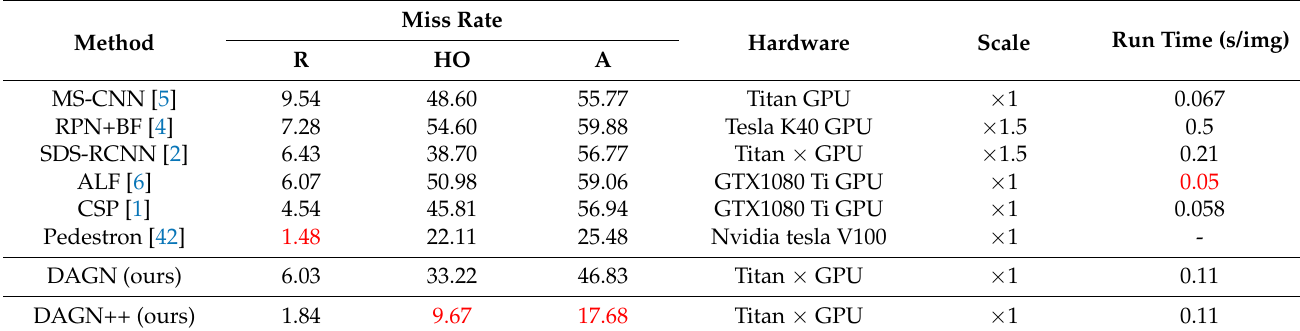
Table 3. Comparisons with the state-of-the-art methods of the Caltech test set. R, reasonable; HO, heavy occlusion; and A, all. Scale × 1 presents original image scale was used for testing. Red color values denote the best